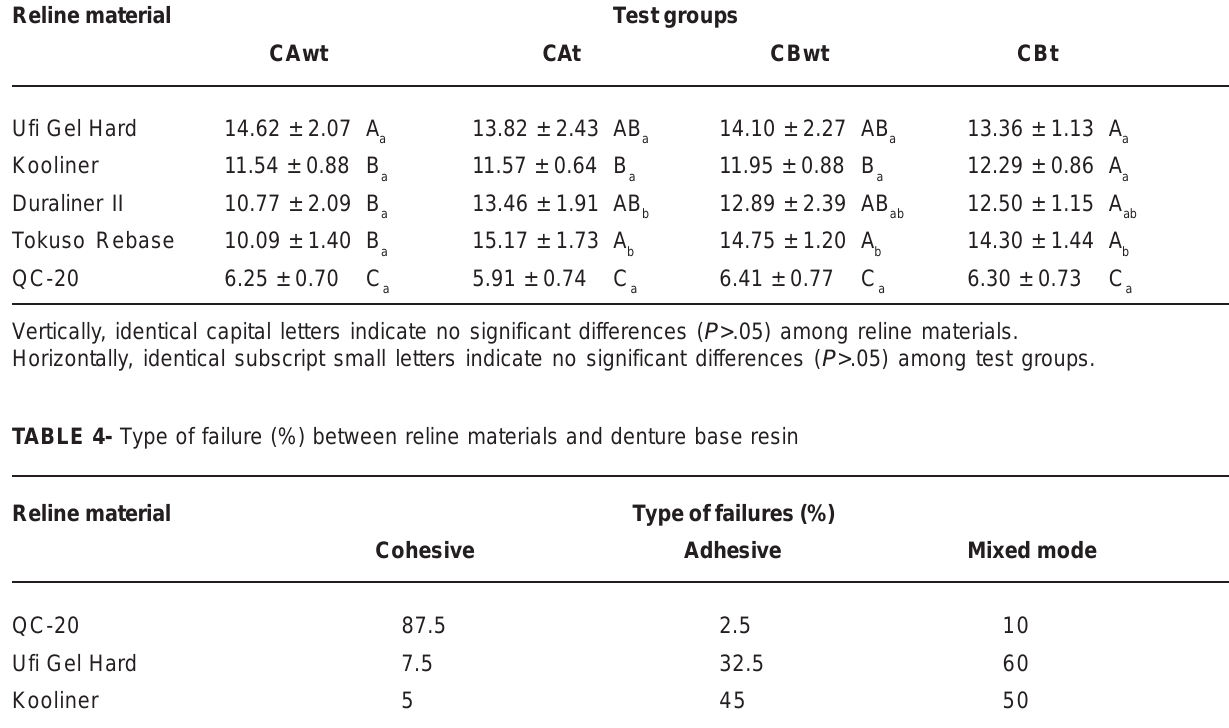
TABLE 3- Mean shear bond strength values (± SD) of reline materials and groups evaluated Reline material